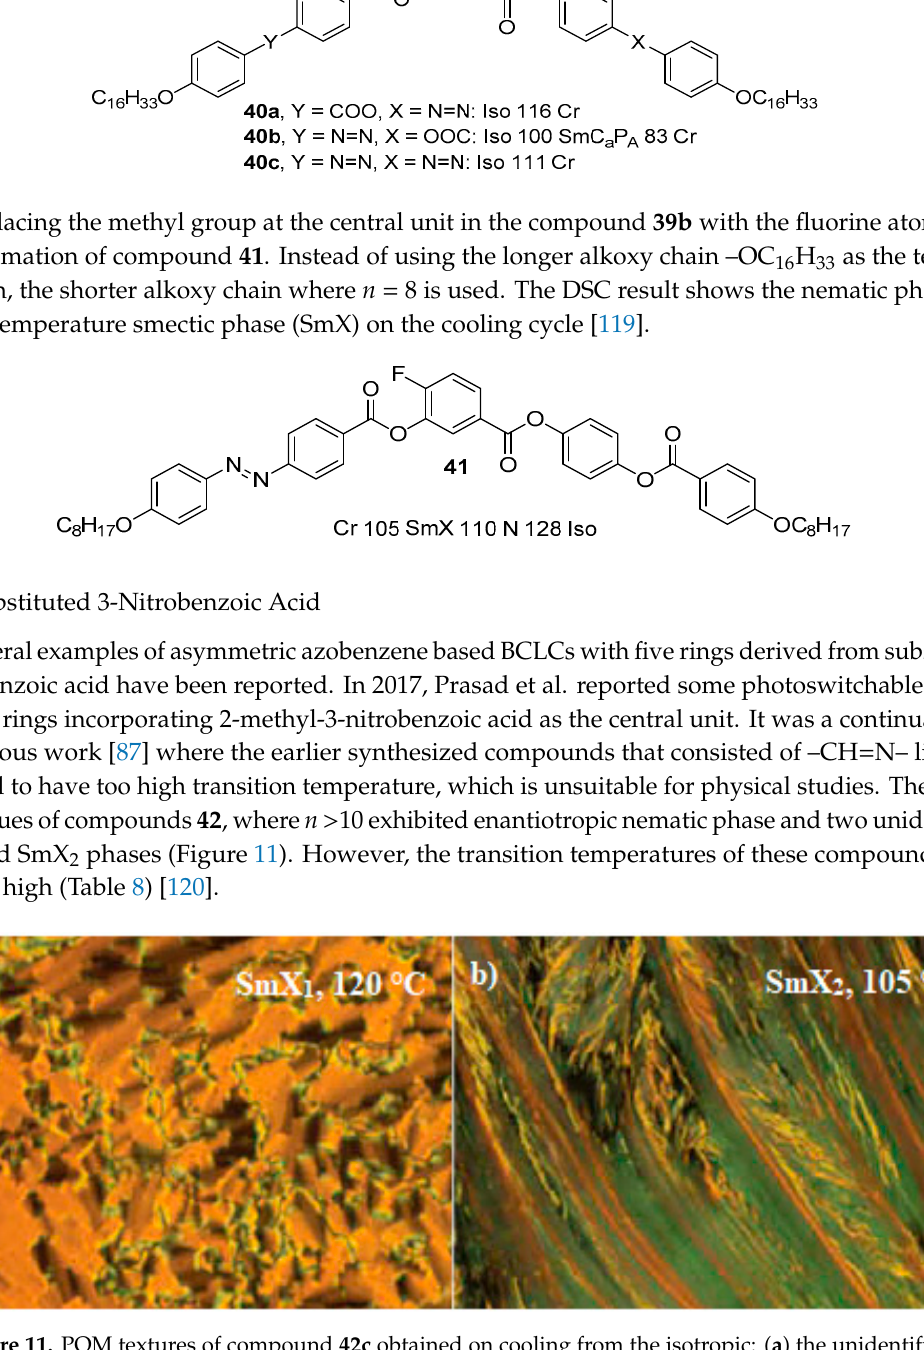
Figure 11. POM textures of compound 42c obtained on cooling from the isotropic: ( a ) the unidentified SmX 1 phase at T = 120 °C and ( b ) the unidentified SmX 2 phase at T = 105 °C [120]. Table 8. Phase transition of compounds 42 .